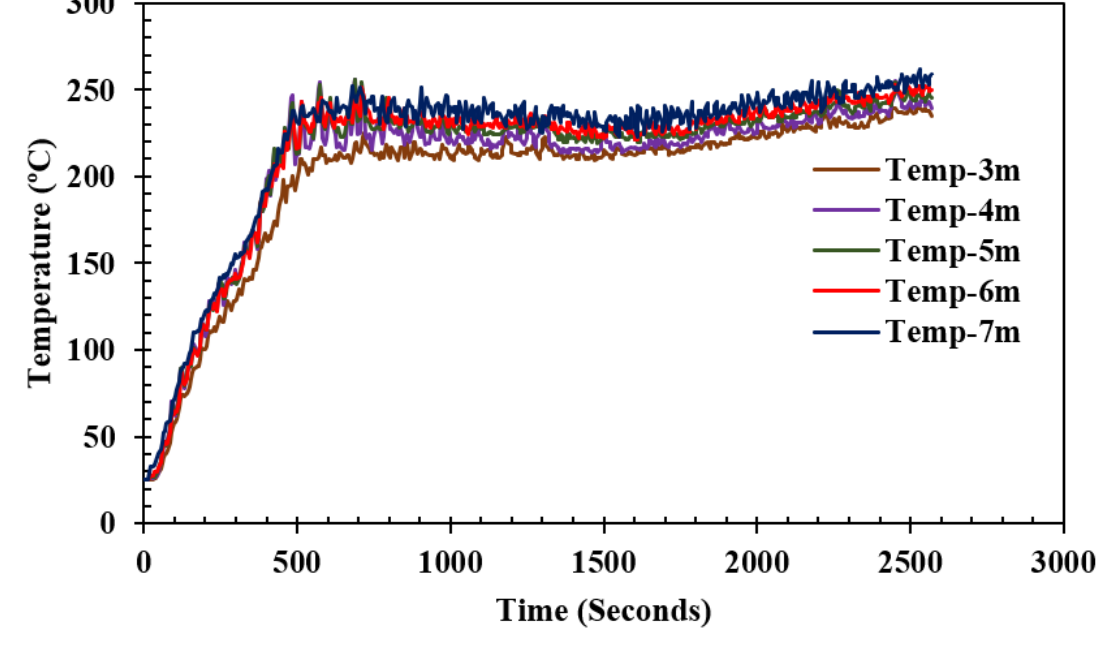
Figure 6. Hot gas layer temperature at various elevations along the center of the room. Temperatures were extracted at five different locations along the centerline of the fire at a distance of 0.1 m, 0.5 m, 1 m, 1.5 m, and 2 m along the z-direction. The temperatures predicted from the simulations are shown in Figure 7. As observed in the plot, the highest temperatures are obtained at the location closest to the fuel surface, i.e., at 0.1 m, while the temperatures predicted at subsequent heights decrease. This can be explained by the same phenomenon of maximum mixing near the fuel surface earlier explained for the centerline temperatures obtained for the validation case. The temperatures seem to rise for 500 s, after which they attain a steady state. For a better understanding of the centerline temperature, a contour plot for the mean value of the centerline temperature is obtained and shown in Figure 8